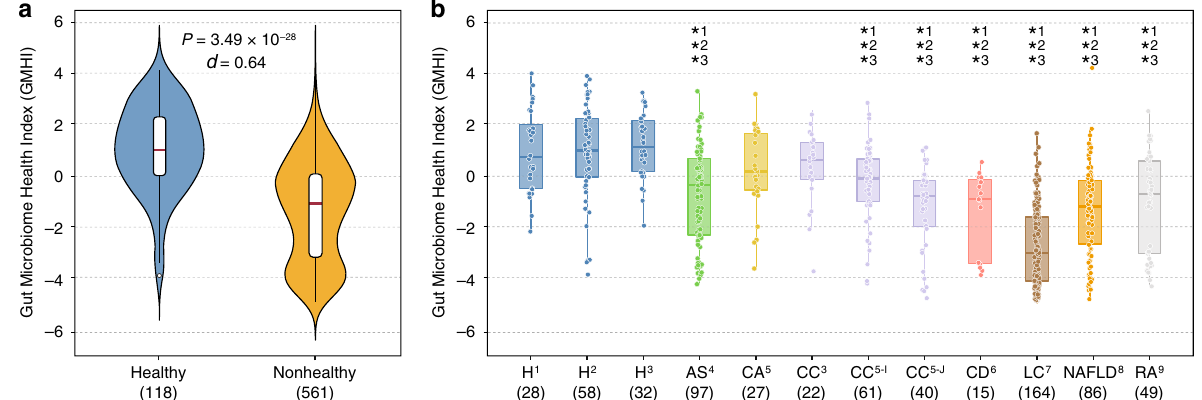
Fig. 6 GMHI demonstrates strong reproducibility on an independent validation cohort. The validation cohort (679 stool metagenome samples) consisted of 12 total sub-cohorts ranging across eight healthy and nonhealthy phenotypes from nine different studies. a GMHIs from stool metagenomes of the healthy group were signi fi cantly higher than those of the nonhealthy group (two-sided Mann – Whitney U test, P = 3.49 × 10 − 28 ). d Cliff ’ s Delta. b All three healthy sub-cohorts (H 1 , H 2 , and H 3 ) were found to have signi fi cantly higher distributions of GMHI than seven (of nine) nonhealthy sub-cohorts (AS 4 , CC 5-I , CC 5-J , CD 6 , LC 7 , NAFLD 8 , and RA 9 ). No signi fi cant differences were found among H 1 , H 2 , and H 3 . The number in superscript adjacent to phenotype abbreviations corresponds to a particular study used in validation (see Supplementary Table 5 for study information). Standard box-and-whisker plots (e.g., center line, median; box limits, upper and lower quartiles; whiskers, 1.5× interquartile range; points, samples) are used to depict groups of numerical data. *Signi fi cantly higher distribution in healthy sub-cohort (two-sided Mann – Whitney U test, P < 0.01). The number adjacent to * indicates the healthy sub-cohort (H 1 , H 2 , or H 3 ) to which the respective sub-cohort was compared. The sample size of each group or cohort is shown within parentheses. AS ankylosing spondylitis, CA colorectal adenoma, CC colorectal cancer, CD Crohn ’ s disease, H healthy, LC liver cirrhosis, NAFLD, nonalcoholic fatty liver disease, RA rheumatoid